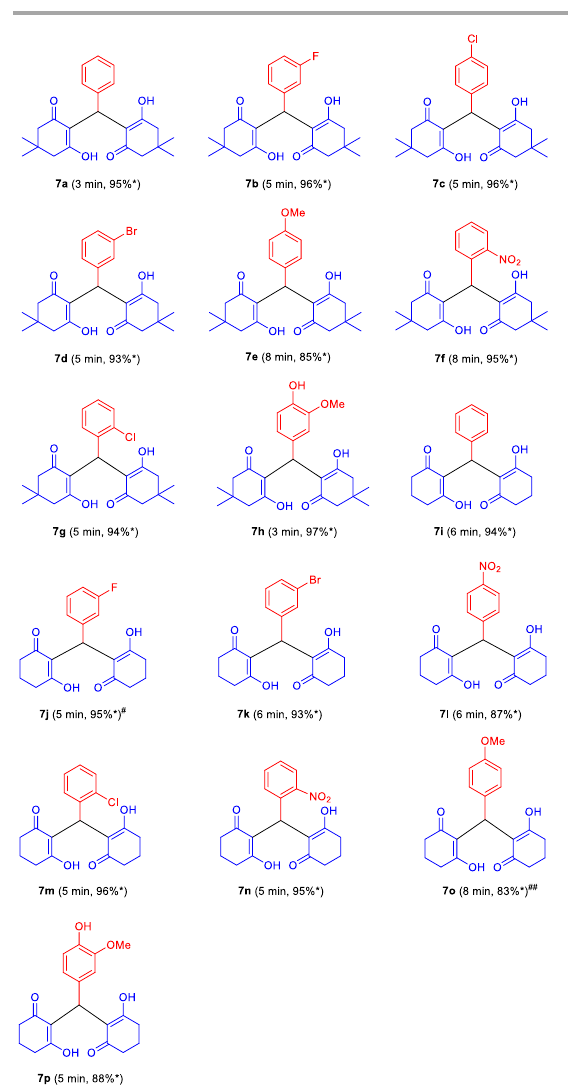
Table 5. Substrate scopes for the synthesis of 2,2 ′ -aryl/heteroaryl-methylene-bis(3-hydroxy-cyclohex-2-enone)